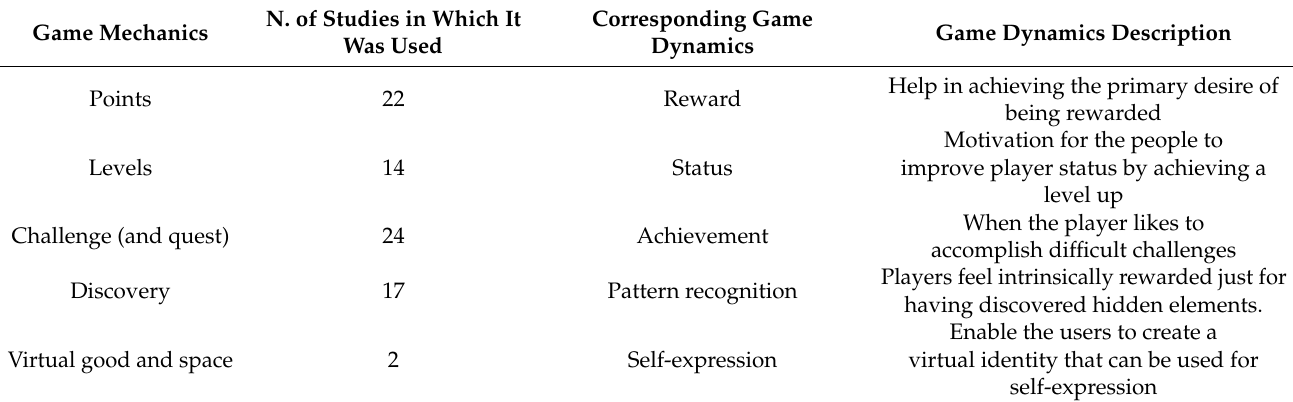
Table 2. Game mechanics used in the retained studies and their corresponding game dynamics. Some studies are described with more than one game